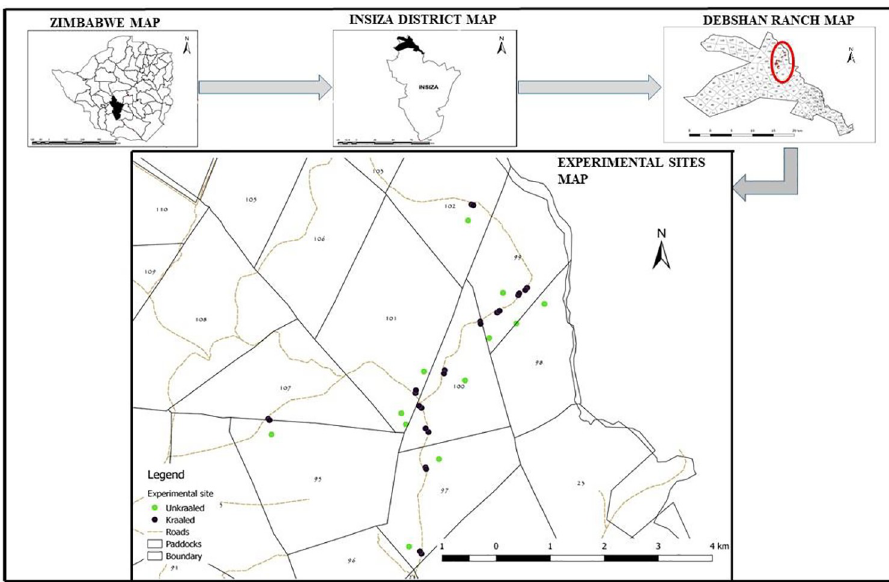
Fig 1. Debshan ranch location showing camera trap